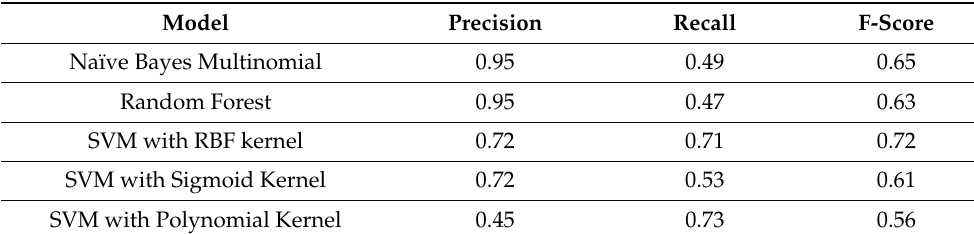
Table 2. Performance evaluation of analyzed models.